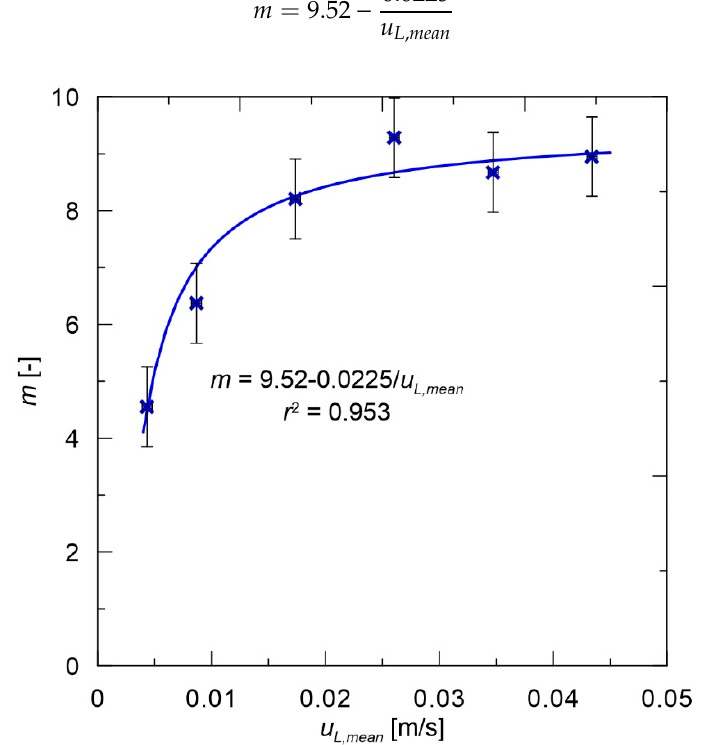
Figure 3. Value of the parameter m versus mean liquid velocity, u L , mean .